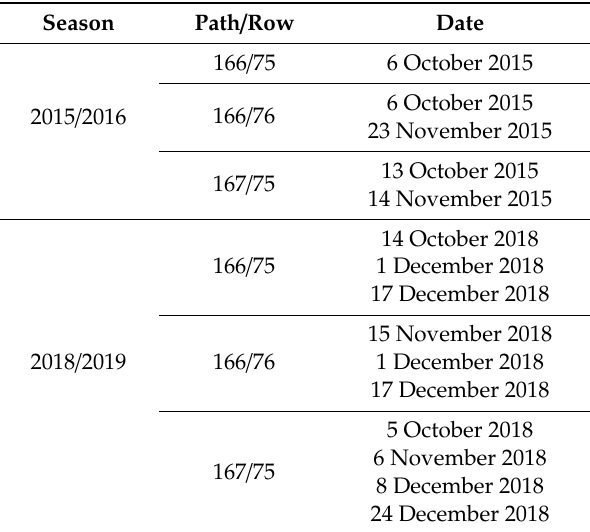
Table 1. Landsat 8 OLI / TIRS used in this study.